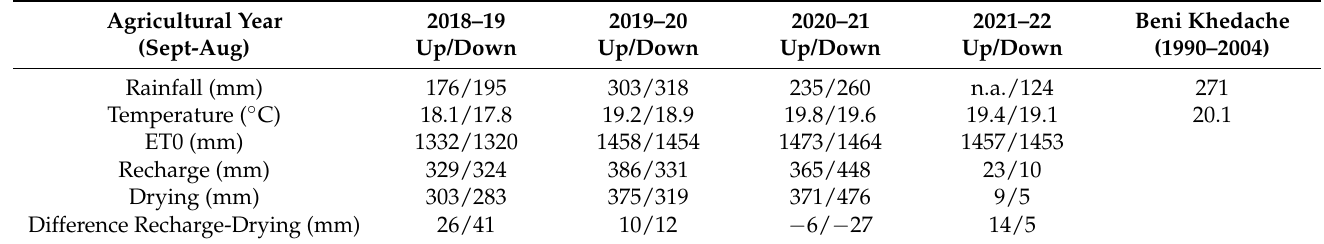
Table 3. Annual meteorological values for the upstream/downstream Jessour for the four observed agricultural years (September–October): rainfall, temperature, evapotranspiration, recharge and drying of the 1.25 m soil profile. Mean annual rainfall and temperature in Beni Khedache (1990–2004) in southeast Tunisia, according to the National Meteorological Institute of Tunisia